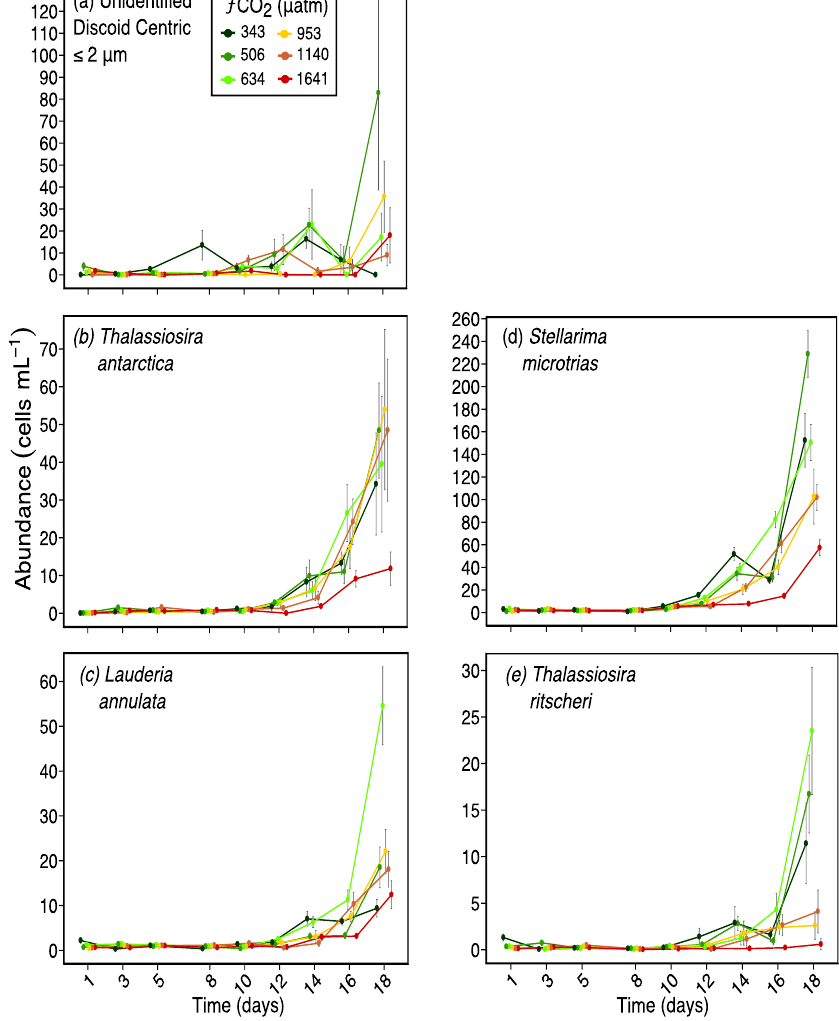
Figure 3. Abundances of (a) unidentified discoid centric diatoms (valve diameter) ≤ 2µm; (b) Thalassiosira antarctica (valve diame- ter ≈ 20µm); (c) Lauderia annulata (valve diameter ≈ 55µm); (d) Stellarima microtrias (valve diameter ≈ 55µm); and (e) Thalassiosira ritscheri (valve diameter ≈ 50µm) over days 1 to 18 of the incubation of a natural protistan community in tanks maintained at different f CO 2 levels. Error bars are standard errors derived from pseudo-replicates undertaken at each time point for each